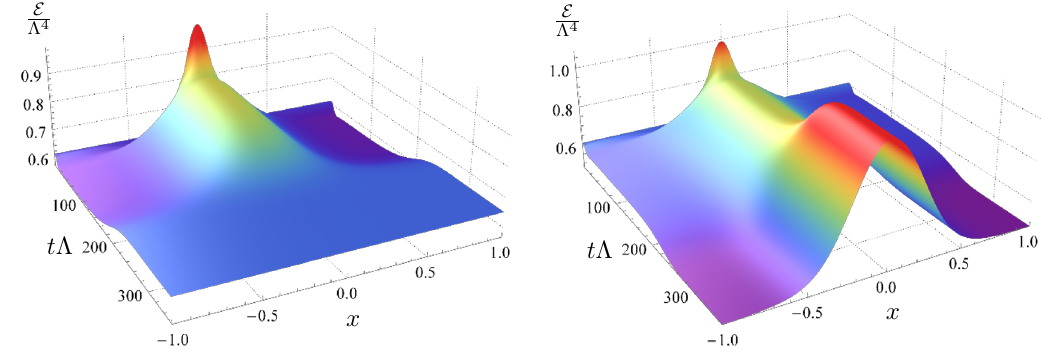
Figure 27 . Zoom-in on the left region of figure 22, where ˆ L ’ 11 . 501849 . X c , X d and X e are the three static solutions with the same average energy density of figure 28(left) corresponds to an evolution from X c to X d , and figure 28(right) corresponds to an evolution from X c to X e .